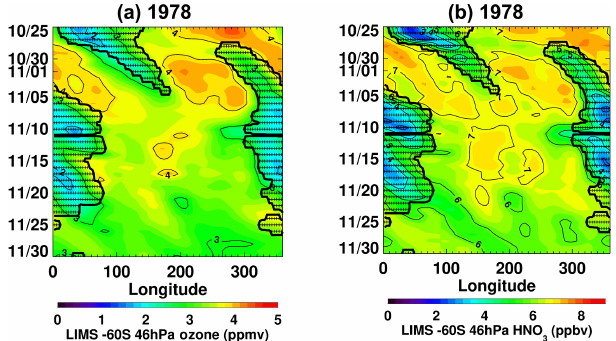
Figure 6. As in Fig. 5, but extended in time from 25 October to 30 November